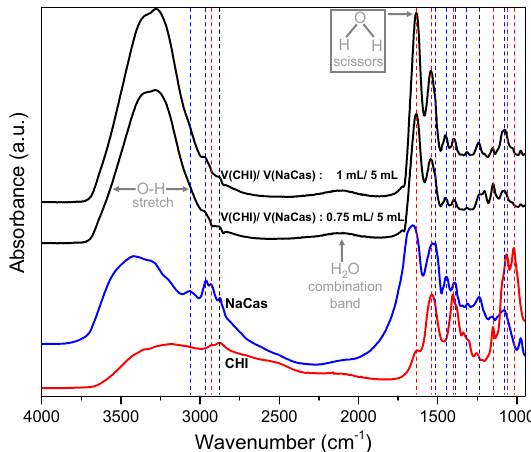
Figure 8. ATR-FTIR spectra of chitosan-caseinate hydrogel nanoparticles (NPs) collected in the centrifugates of the experiment (iv) of Case II (caseinate in excess), in which 0.75 or 1.00 mL of 0.1% (w/v) solution of HMW CHI of low DA = 3% were respectively added to 5.00 mL of 0.1% (w/v) NaCas sub-micellar dispersion system. The ATR-FTIR spectra of the chitosan acetate (red) and sodium caseinate (blue) are also displayed, and the dashed lines (red or blue, respectively) highlight the relevant peaks of these polymer constituents in the CHI-caseinate hydrogel NPs. The grey arrows highlight the absorption bands of the water present in the hydrogel NPs.